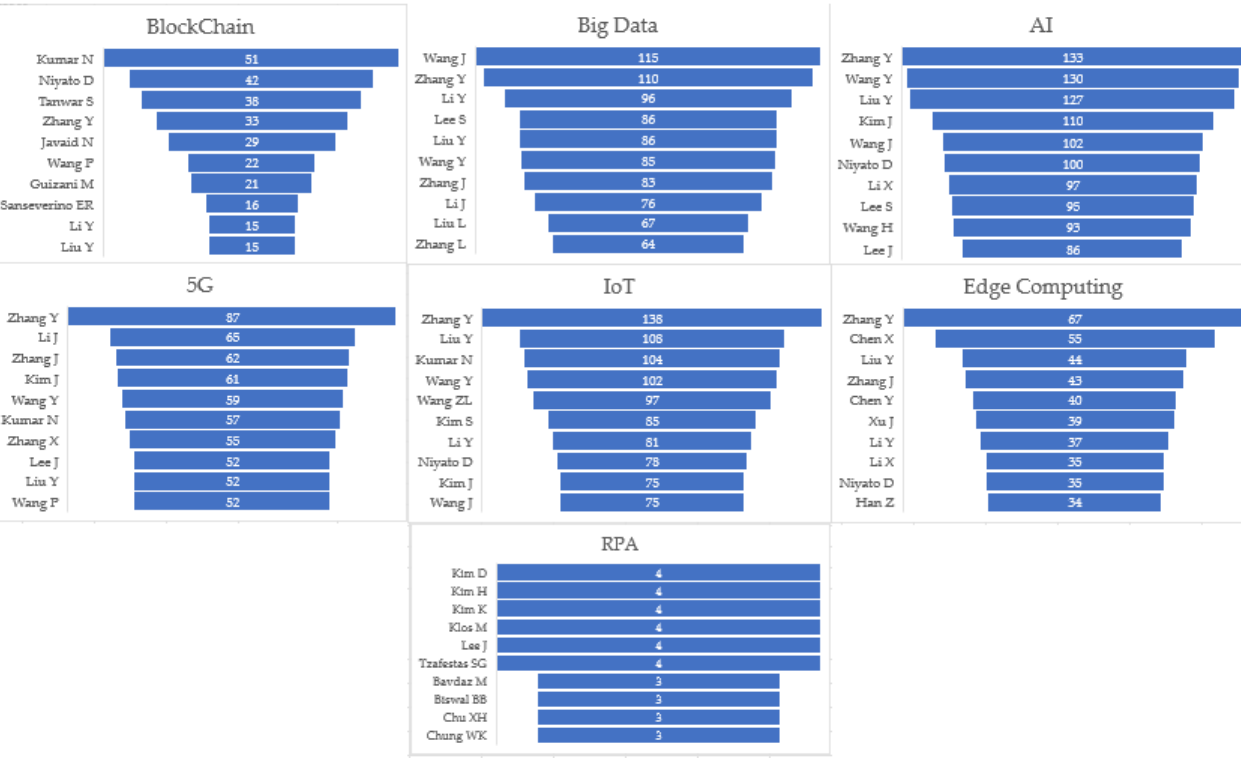
Figure 7. Publication analysis by authors.